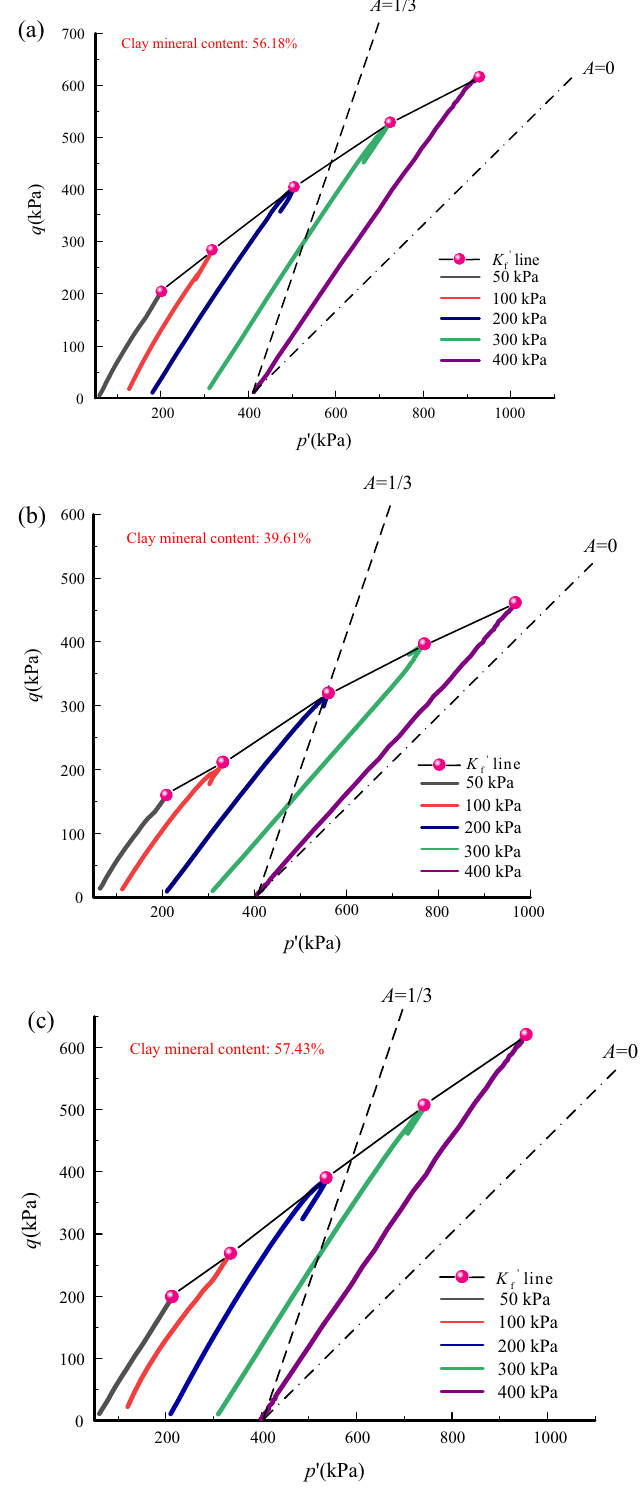
Figure 9. Stress path and K f line of tailings samples: ( a ) CTI, ( b ) CTII, ( c )